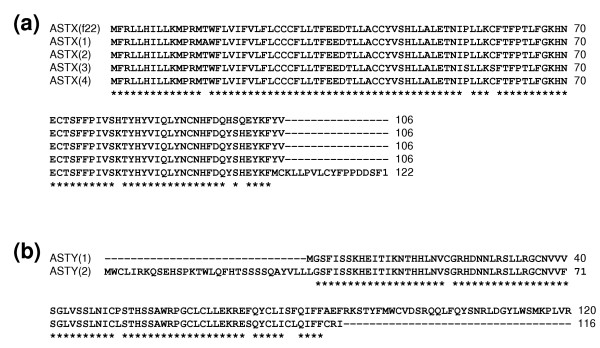
A comparison of the protein encoding potentials of Astx and Asty. (a) The predicted protein for the conserved open reading frame in exon 4 of the arrayed Astx clone (f22) and for the four protein variants predicted from the eight putative X chromosomal loci. (b) The two predicted ASTY protein variants encoded by two overlapping open reading frames in exon 1 present in six Asty loci.